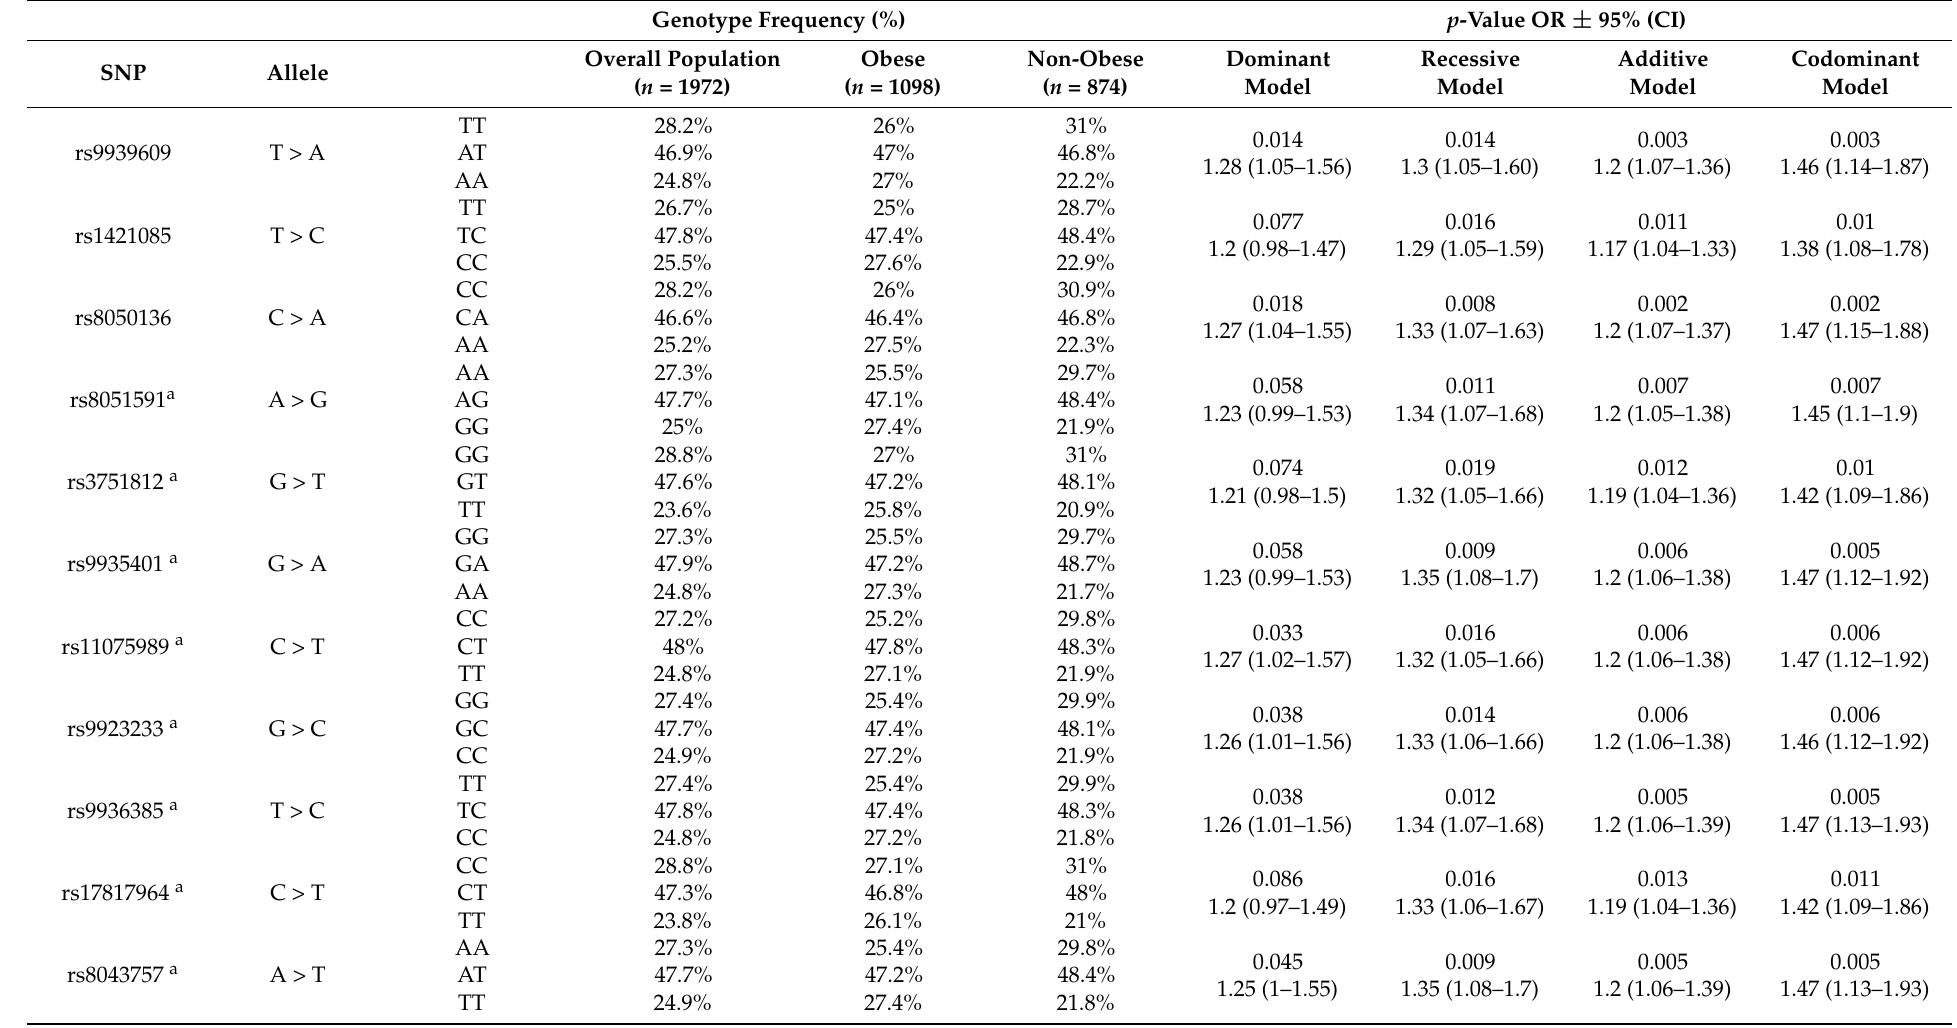
Table 2. Participants’ FTO SNPs genotype frequency and obesity